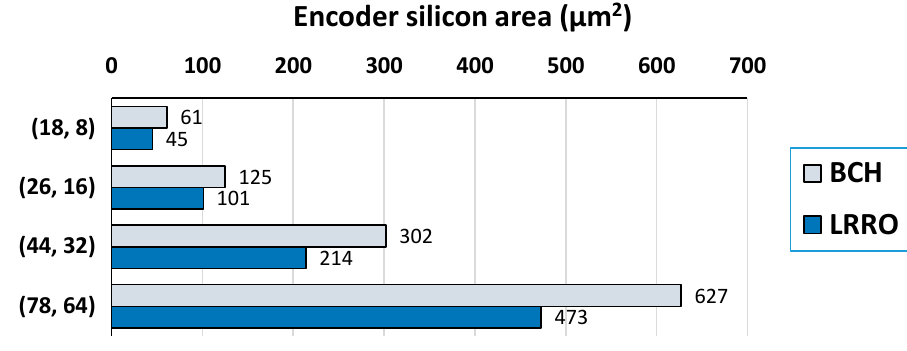
Figure 8. Propagation delay of the decoder circuits (in ps).